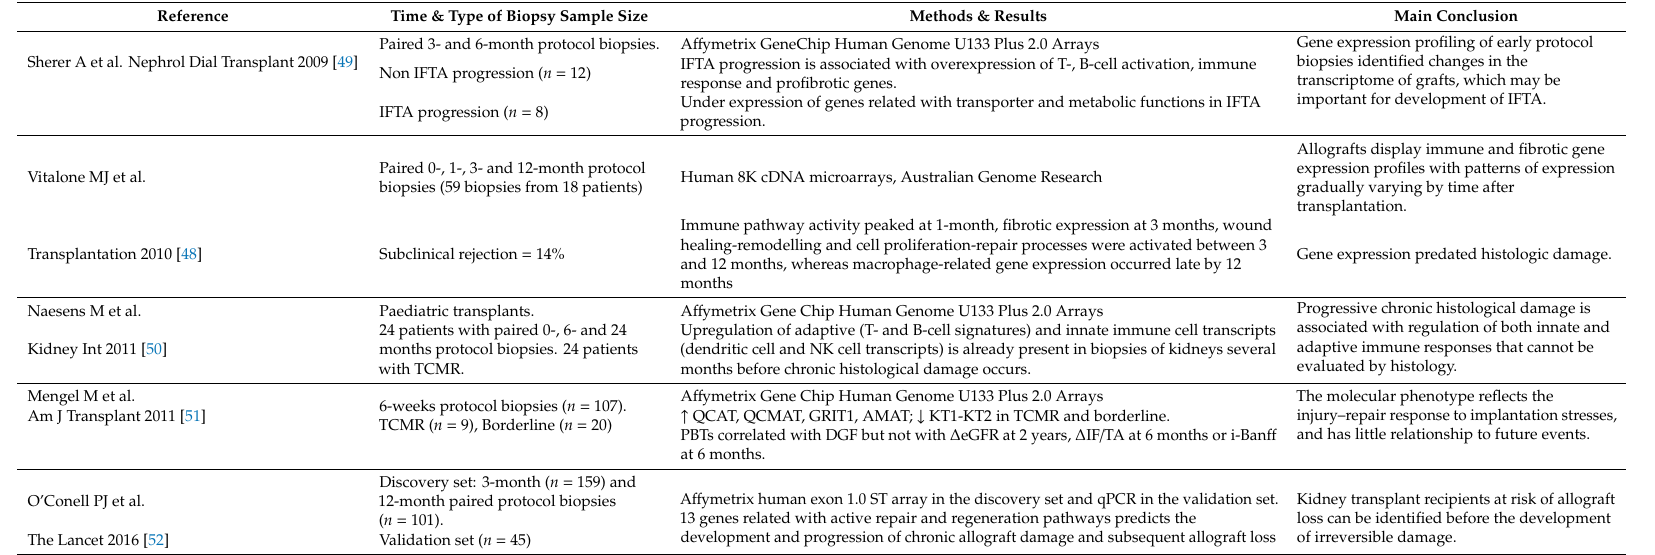
Table 2. Summary of di ff erent studies analyzing the transcriptome on surveillance biopsies. IFTA, interstitial fibrosis and tubular atrophy; TCMR, T-cell mediated rejection; QCATs (infiltration of cytotoxic T cells); GRIT1 (interferon-gamma and rejection-induced transcripts); QCMAT (infiltration of macrophages;